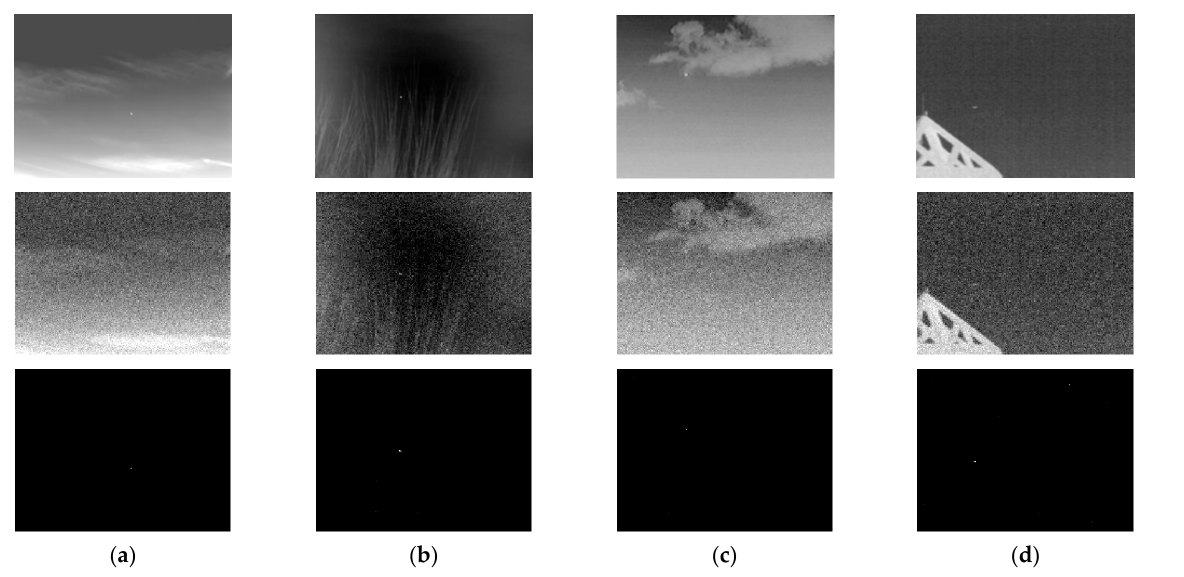
Table 3. Average SCR of the images in Figure